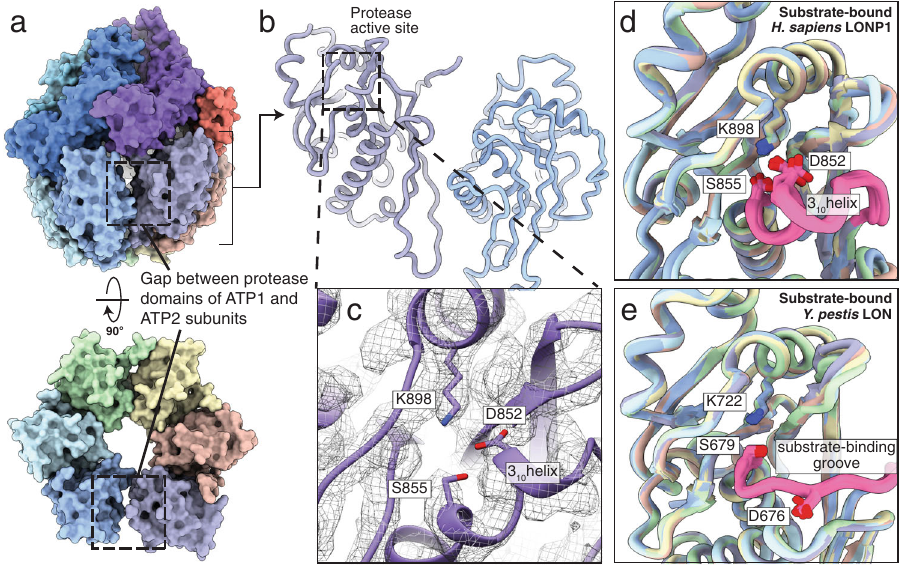
Fig. 3 LONP1 in the substrate-bound conformation contains an inactive protease site. a Surface representation of substrate-bound LONP1 showing a break in the protease domains between the highest subunit, ATP1, and its neighboring subunit, ATP2, highlighted using a dashed box. b The protease domains from ATP1 and ATP2 are shown using a ribbon representation, with the inactive active sites denoted by dashed boxes. c Close-up view of the proteolytic active site highlighting how the loop containing the catalytic serine (S855) is folded into a 3 10 helix and an aspartic acid (D842) prevents the formation of the serine (S855)-lysine (K898) catalytic dyad. The electron microscopy density for this region is shown as a gray mesh. d Superimposing the six protease domains of the substrate-bound H. sapiens LONP1 shows that all protease domains adopt an inactive conformation, despite having substrate bound within the ATPase channel. e A superimposition of all six protease domains in substrate-bound Y. pestis LON shows that all protease domains adopt an activated conformation where the 3 10 helix has unfolded to produce a binding groove to receive substrate, the aspartic acid (D676) is moved away from the active site, and the serine (S679)-lysine (722) catalytic dyad is positioned for peptide